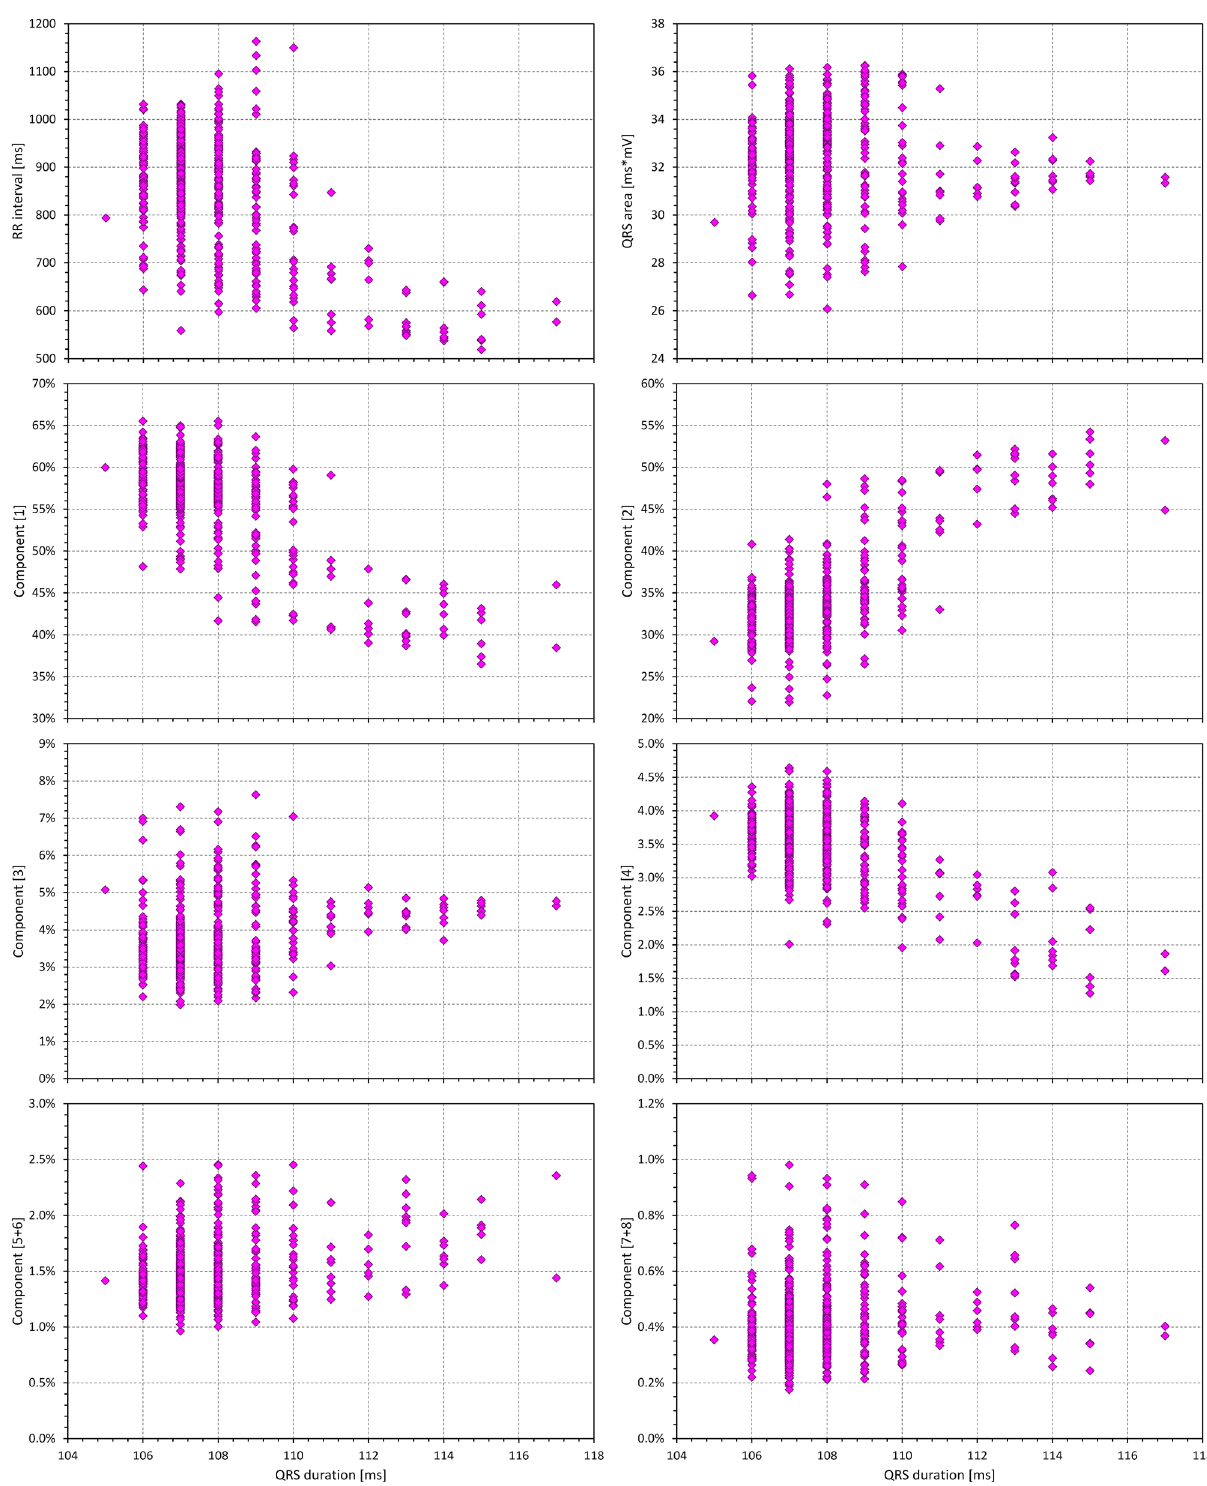
Figure 3. Example of relationship between measured values in the same 23-year old male as presented in Fig. 2. Individual panels show the dependency of absolute QRS area and of selected orthogonal components and their combination on the QRS duration. For completeness, the inverse relationship between the QRS duration and the RR interval of the underlying heart rate is also shown. The layout of the panels corresponds to that of Fig.